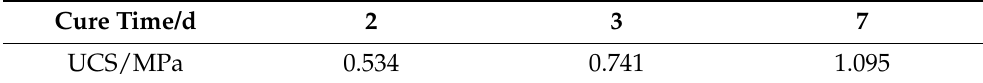
Table 4. Variation in UCS with curing time.